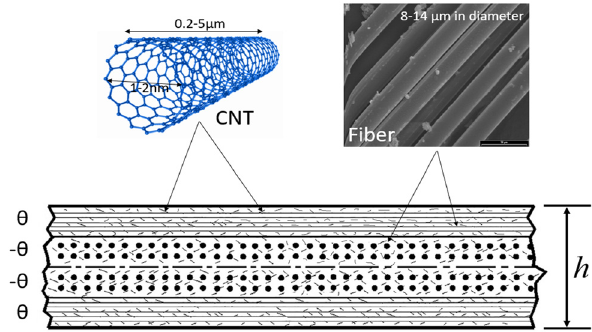
Figure 1: Symmetric cross - ply laminated CNT/ fi ber/polymer multi - phase composite [ 9 ]